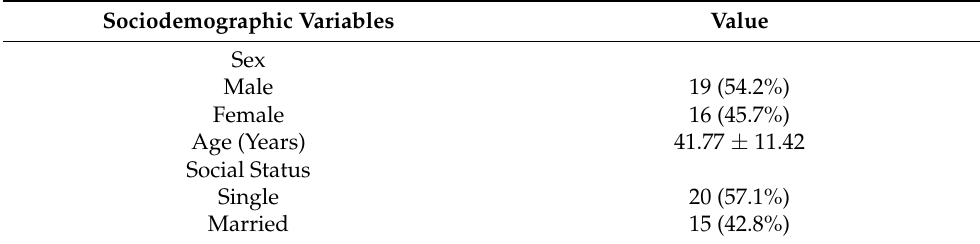
Table 1. Sociodemographic characteristics of the